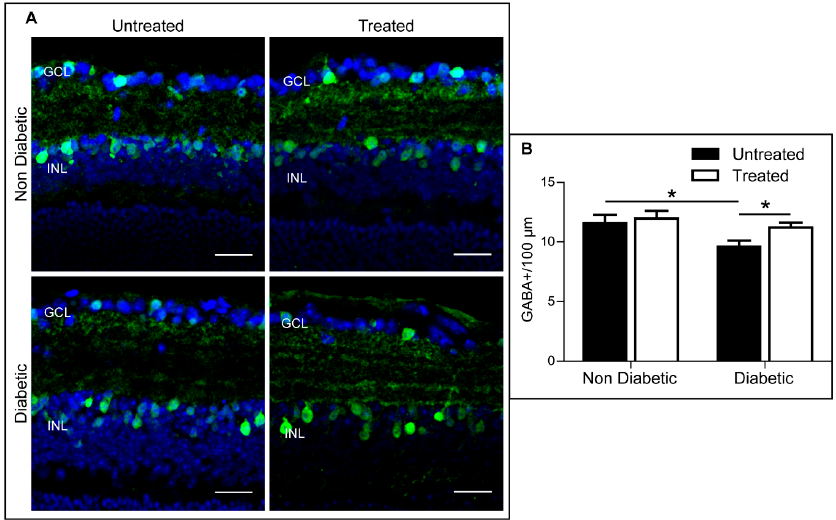
Figure 5. 3TC attenuates diabetes-mediated GABAergic amacrine cell loss . Cryosections from each experimental condition were stained for GABA (green) and counterstained with DAPI (blue). The average number of GABAergic amacrine cells within the INL were quantified and normalised to 100 μ m of retina length. ( A ) Representative images for each condition. GCL: ganglion cell layer; INL: inner nuclear layer. Scale bar: 25 μ m. ( B ) Average number of GABAergic amacrine cells per 100 μ m. Data are shown as mean ± SEM. n > 30 images from 3–5 different animals per experimental condition. Two-way ANOVA with Sidak’s test, * p < 0.05. Int. J. Mol. Sci. 2018 , 19 , x FOR PEER REVIEW